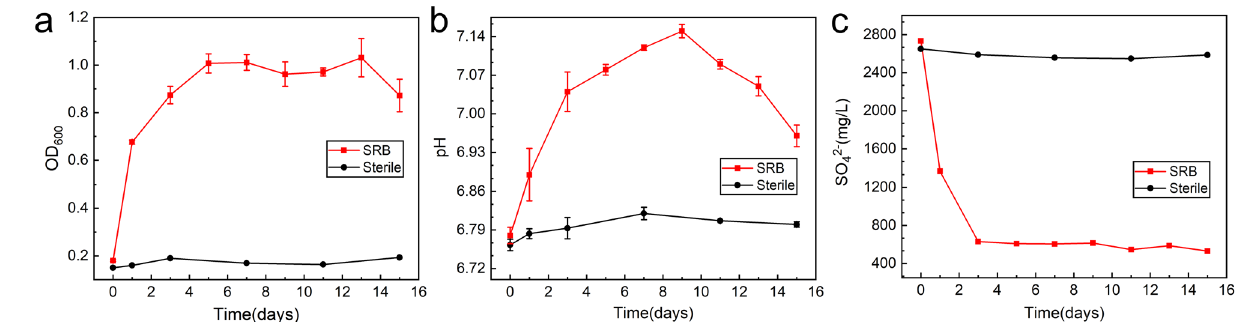
Fig. 7 Growth process of D. bizertensis SY-1 strain. a Growth curve, b pH, and c SO 42 − values of the Q235 coupons in the sterile and SY-1 inoculated culture media after different days (error bars stand for the standard deviations from three independent